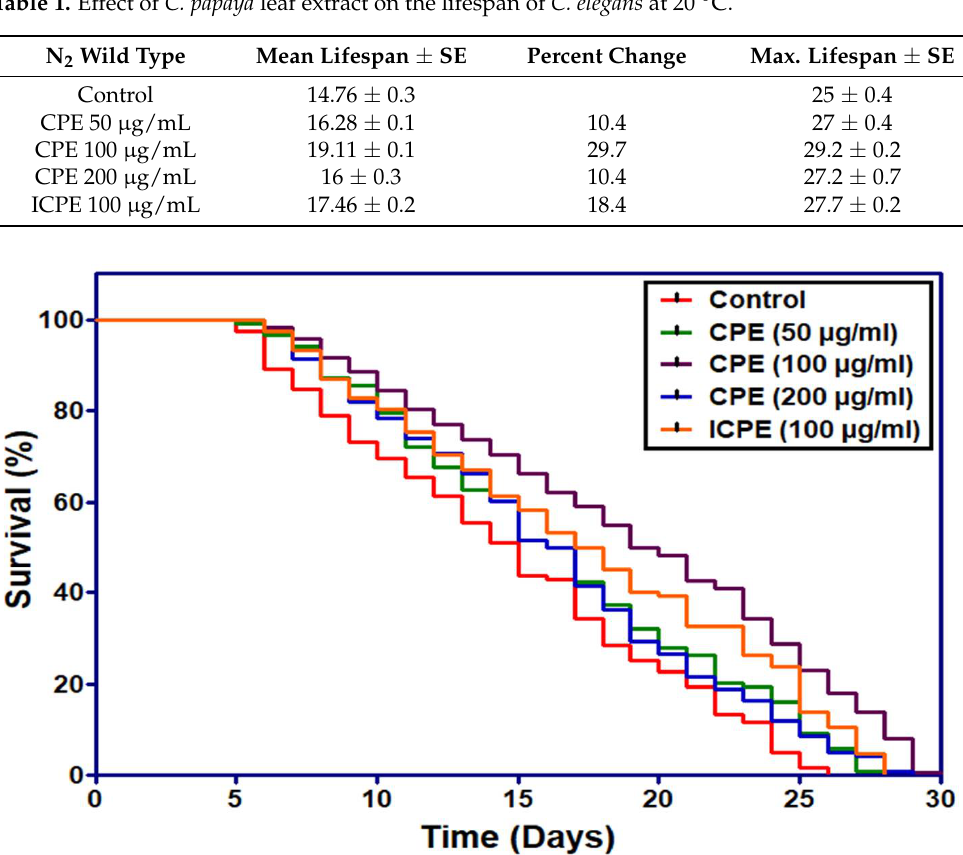
Figure 10. Effect of papaya leaf extract supplementation on lifespan of wild-type C. elegans .